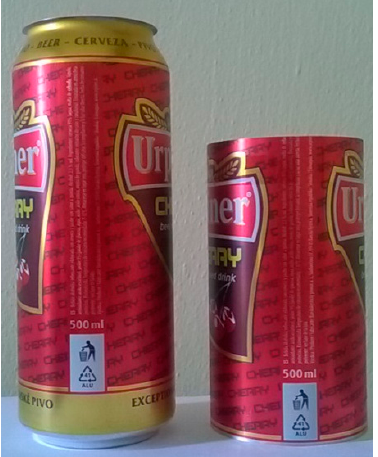
Figure 3. Can and manufactured specimen.